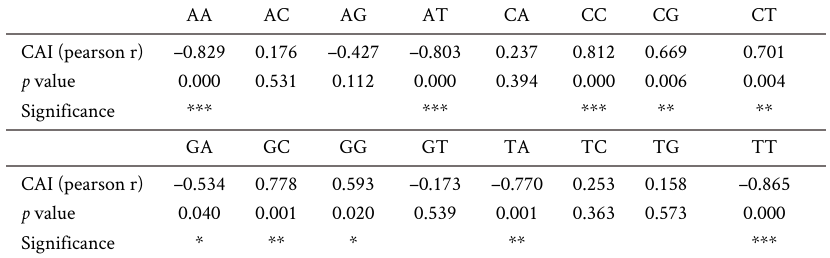
Table 1. Correlation analysis between the odds ratio and CAI value.